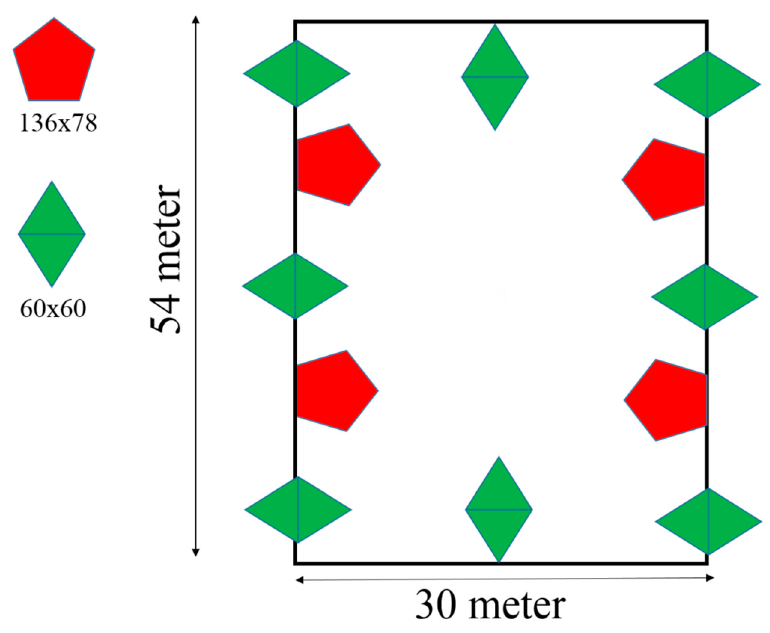
Figure 8. Proposed setup of the LED construction with two light distribution patterns.